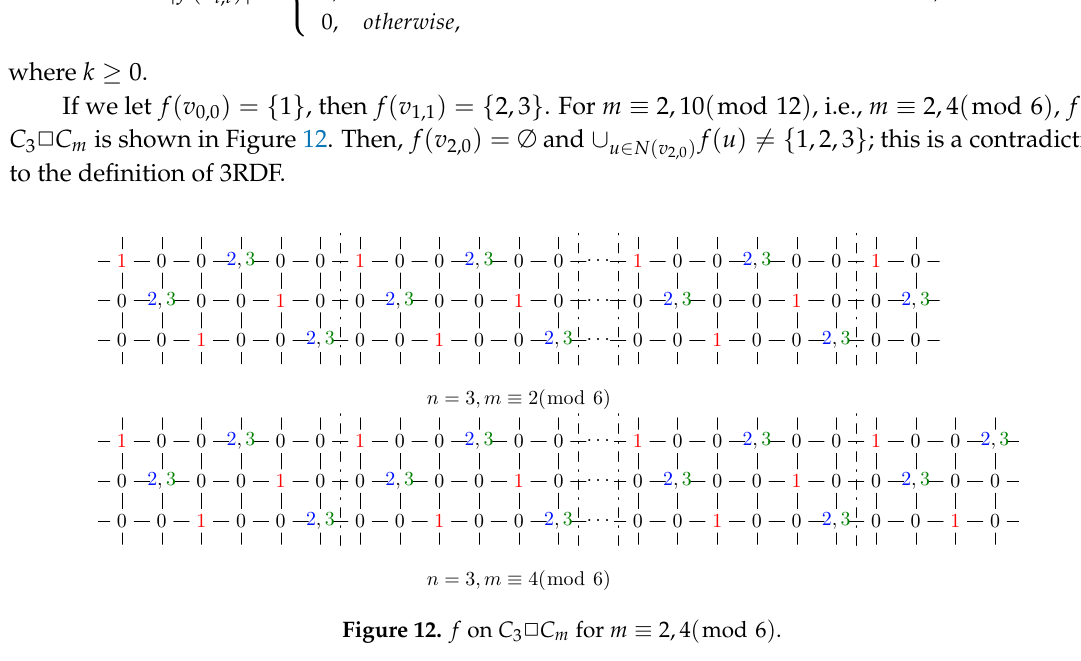
Figure 12. f on C 3 2 C m for m